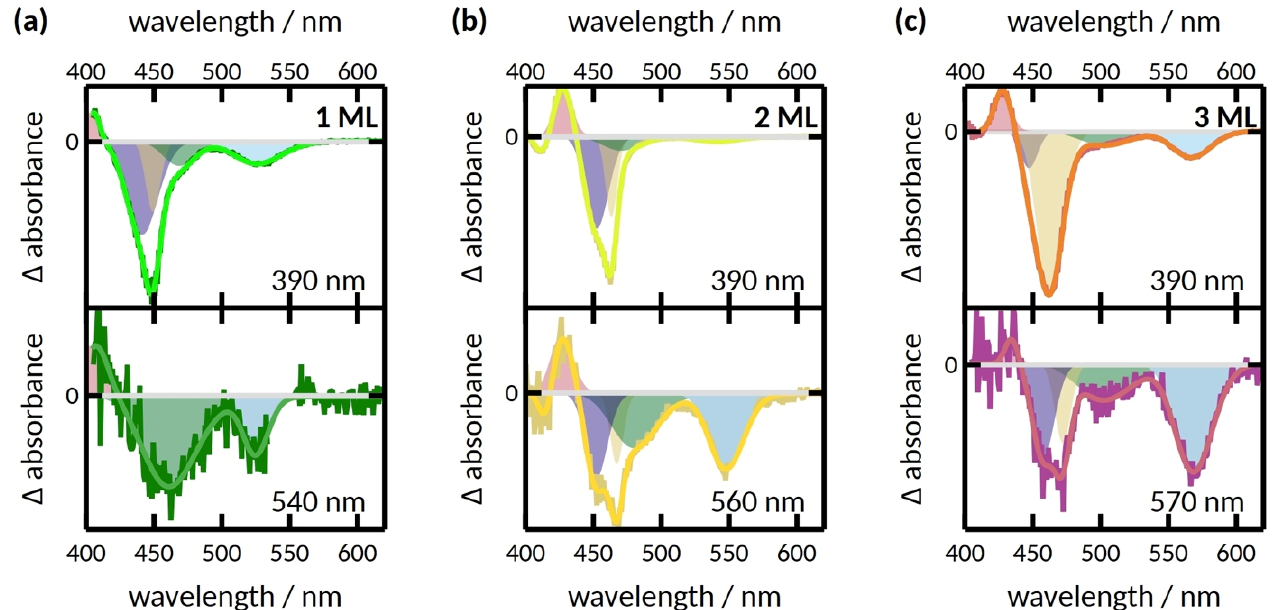
Figure 4. Transient spectra obtained at a delay time of 20 ps upon CdS rod (top) or CdSe seed (bottom) excitation of ( A ) 1 ML, ( B ) 2 ML, and ( C ) 3 ML. A multi-Gaussian fit to accurately describe the spectra is shown as shaded areas and the cumulative fit is shown as a solid line.